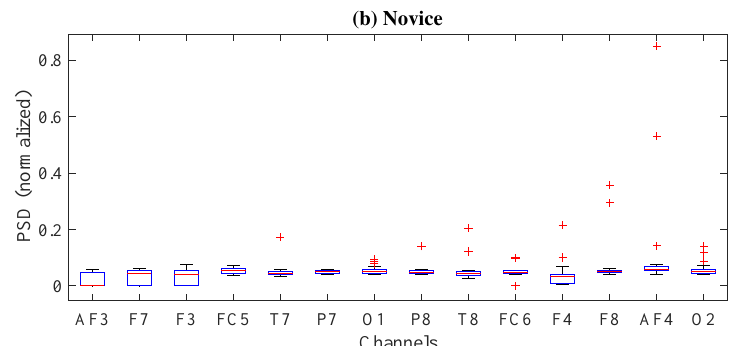
Figure 5. Box-plot for the normalized power spectral densities of fourteen EEG channels for ( a ) expert players and ( b ) novice players. The + symbol represents the outliers; the rectangular box shows the region between the first and third quartile; and the red line shoes the median values.